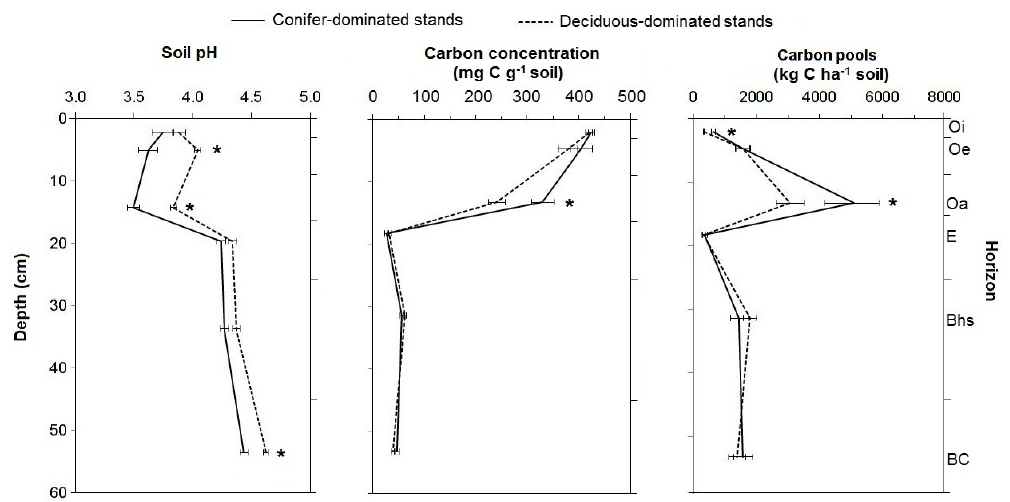
Figure 1. Soil pH, carbon concentration, and carbon pools for soil horizons at conifer- and deciduous-dominated stands. Mean values are given ± 1 standard error. An asterisk indicates a significant difference using two-sample t tests ( P <0.05).